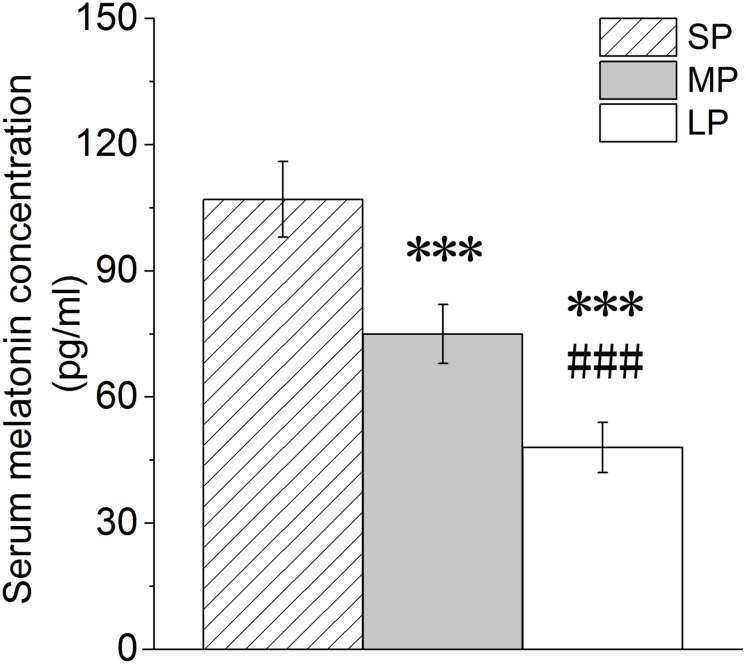
Changes in melatonin level in blood of hamsters in three photoperiodic groups. Values are means ± SD. n = 20. SP, short photoperiod; MP, moderate photoperiod; LP, long photoperiod.*⁣**P < 0.001 compared with SP; ###P < 0.001 compared with MP.